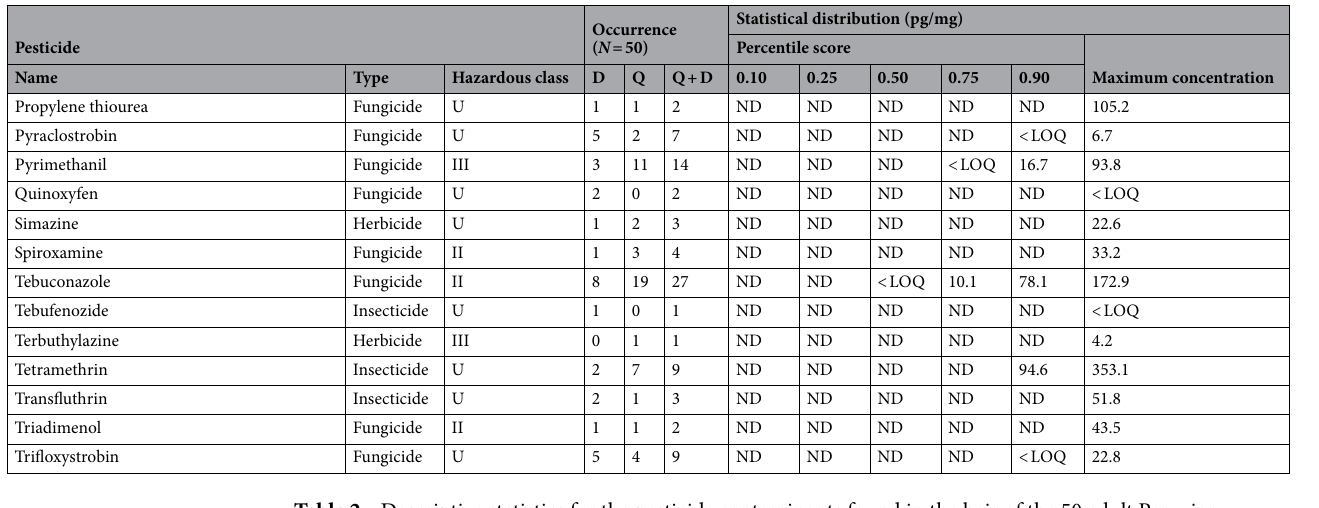
Table 2. Descriptive statistics for the pesticide contaminants found in the hair of the 50 adult Peruvian participants in the study. D, number of subjects for whom analyte was only detected; Q, number of subjects for whom analyte was quantifiable; Q + D, number of subjects for whom analyte was either quantified or detected; ND, not detected. Hazardous classes are defined according to the WHO recommended classification of pesticides by hazard (2019 edition), such as: Class Ia, extremely hazardous; Class Ib, highly hazardous; Class II, moderately hazardous; Class III, slightly hazardous; U, unlikely to present acute hazard. *Pesticide ingredients and derivative metabolites banned in